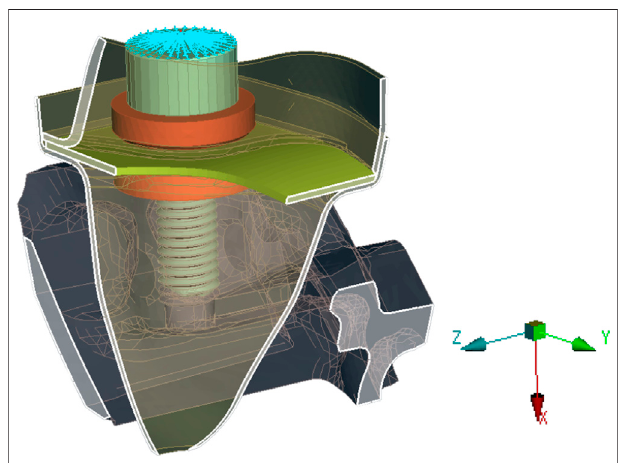
FIGURE 3 | FE model of the cut section of the carburetor indicating the boundary condition surfaces.